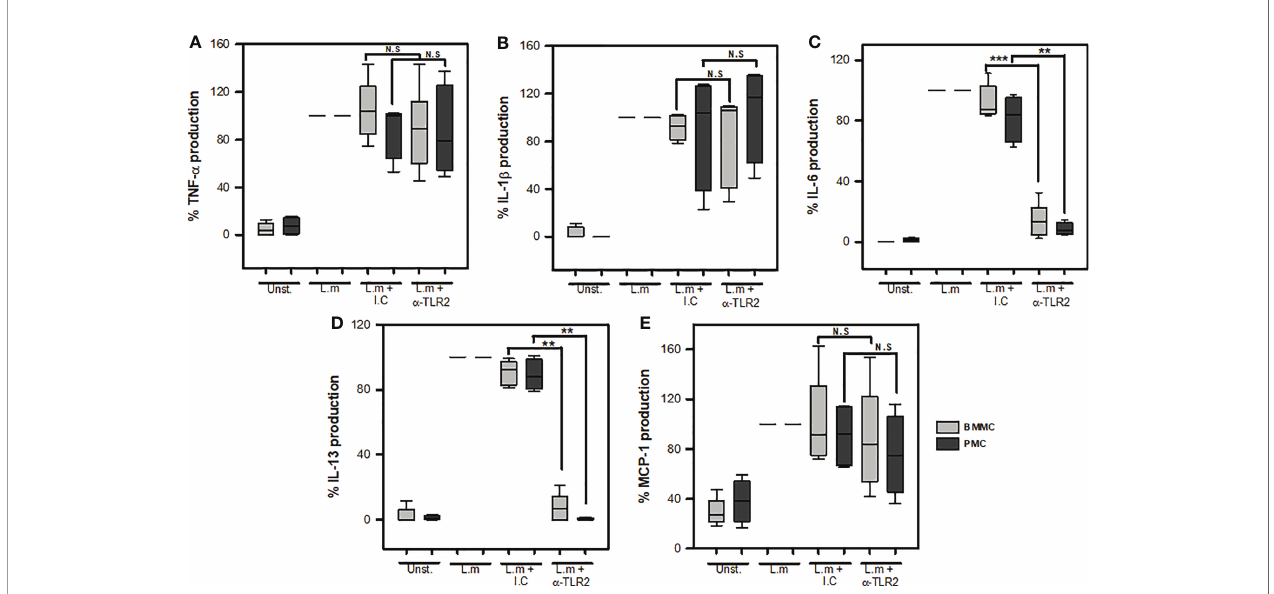
FIGURE 5 | Mast cells TLR2 is required for IL-6 and IL-13 production in response to Listeria monocytogenes . 2.5x10 5 BMMC or 2.5x10 5 PMC in 0.25 mL of complete medium were preincubated with anti-TLR2 for 30 minutes and then were stimulated with L.m (MOI 100:1) for 24 h. Mediators levels were evaluated in culture supernatants by ELISA. (A) TNF- a , (B) IL-1 b , (C) IL-6, (D) IL-13 and (E) MCP-1. Data are expressed as percentage of cytokine production, considering as 100% the production induced for L.m only. (Sum of 6 independent experiments, n=6 per group and for each mediator for BMMC (light grey boxes); sum of 4 independent experiments, n=4 per group and for each mediator for PMC (dark grey boxes); N.D, Not detected; N.S, Not Signi fi cance; **p<0.01, ***p<0.001; Kruskal-Wallis